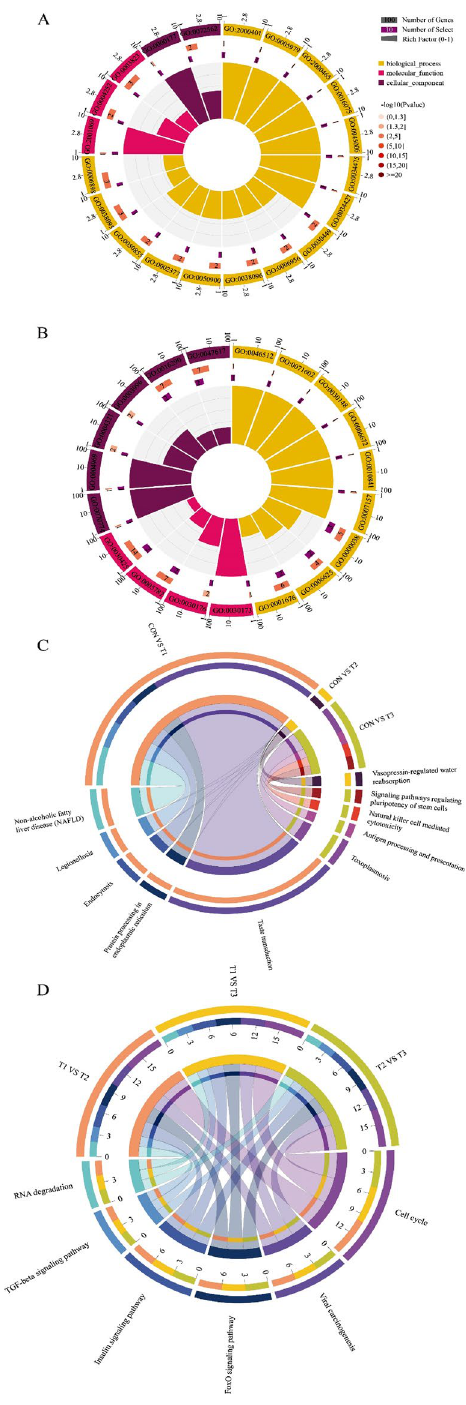
Figure 2. The function of differentially expressed mRNAs was analyzed by KEGG and GO enrichment. GO enrichment of comparison between yak and cattle ( A ) and comparison among yaks living at three different altitudes ( B ). The results from the enrichment analysis are presented using an enrichment cycle diagram. Four circles were included from the outside to the inside. The first circle indicates the enrichment classification. The number of genes (scale) is shown outside of the circle. Different colors represent different categories. The second circle shows the number of background genes in the categories and their Q or P values. A longer bar indicates a higher number of genes, and a redder color indicates a smaller value. The third circle shows the total number of differentially expressed genes in the categories. The fourth circle presents the RichFactor value of each category (the number of differentially expressed genes in this category divided by the number of background genes). Each small grid of auxiliary background lines represents 0.1. Analysis of significantly enriched Kyoto Encyclopedia of Genes and Genomes (KEGG) pathways of comparison between yak and cattle ( C ) and comparison among yaks living at three different altitudes ( D ). The significantly enriched KEGG pathways had P values < 0.05. Each line represents a gene, and the number of lines indicates the enriched genes. GO and KEGG analysis was visualized by the OmicShare tools, a free online platform for data analysis (http:// www. omics hare. com/